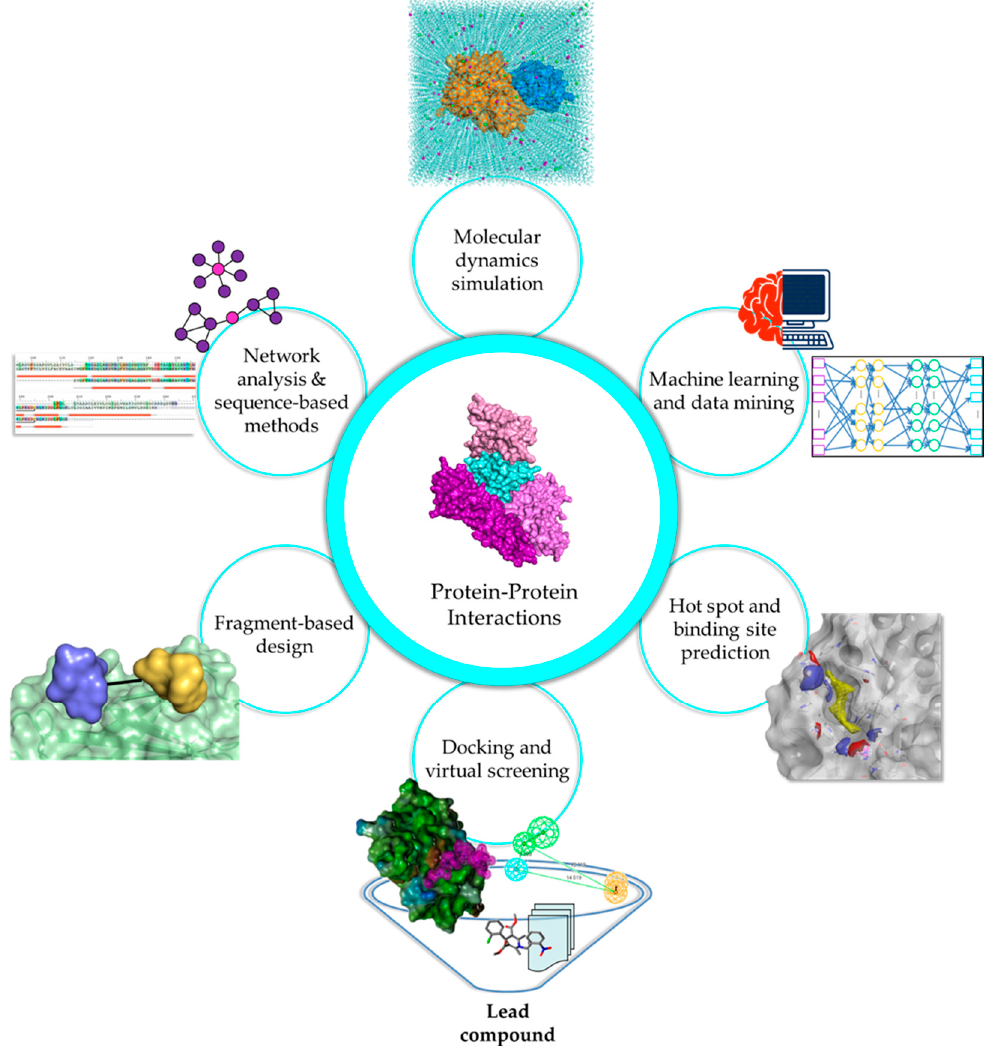
Figure 1. In silico strategies for PPI drug discovery. Diverse computational tools encompass various stages of PPI drug discovery, including the interpretation of protein network topology, the characterization of interface and hot spots, the exploration of PPI chemical spaces for lead discovery and optimization, and the elucidation of complex interactions and dynamics.